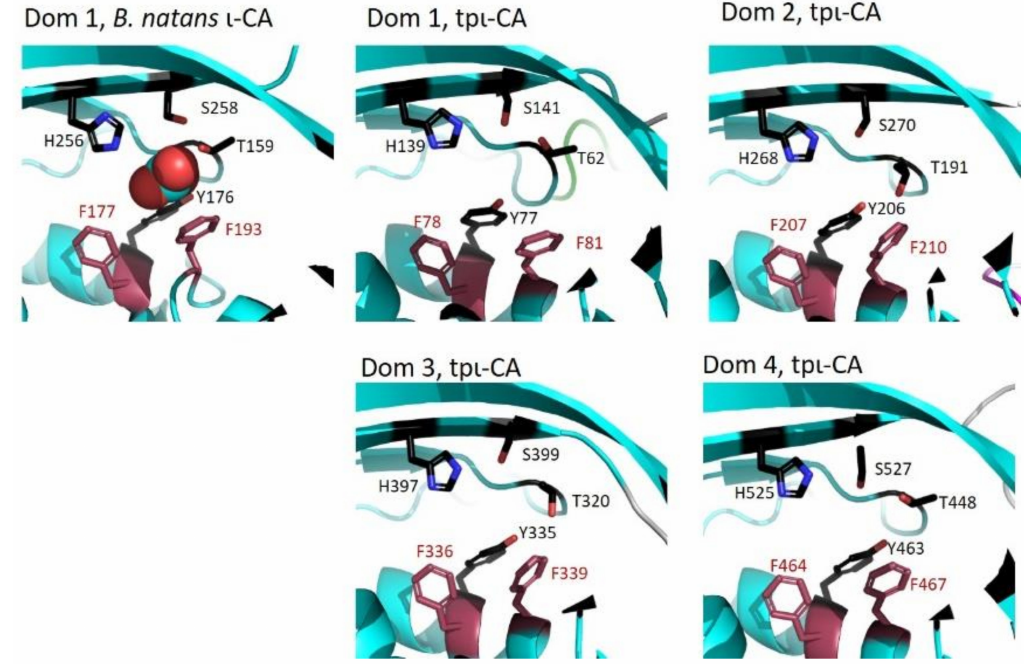
Figure 7. Structure of the ι -CA active site in domain 1 of B. natans ι -CA (pdb 7C5X and of each of the four domains of tp ι -CA (homology